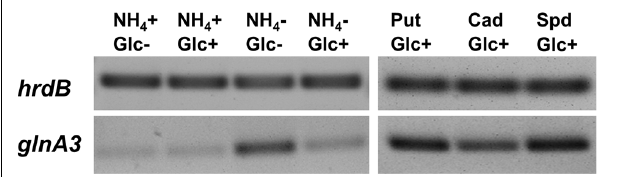
FIGURE 4 | Transcriptional analysis of glnA3 in the presence of polyamines and ammonium as a sole nitrogen sources. Reverse transcriptase/PCR of glnA3 and hrdB (control) from S. coelicolor M145 cultivated in defined Evans medium with low (5 mM) or high (50 mM) concentrations of ammonium chloride or polyamines (Put – putrescine; Cad – cadaverine and Spd – spermidine, 25 mM of each) and glucose as a sole carbon source high Glc+ (25 g/l) or low Glc– (2.5 g/l). Total RNA was isolated from mycelium harvested after 24 h of cultivation in the defined Evans